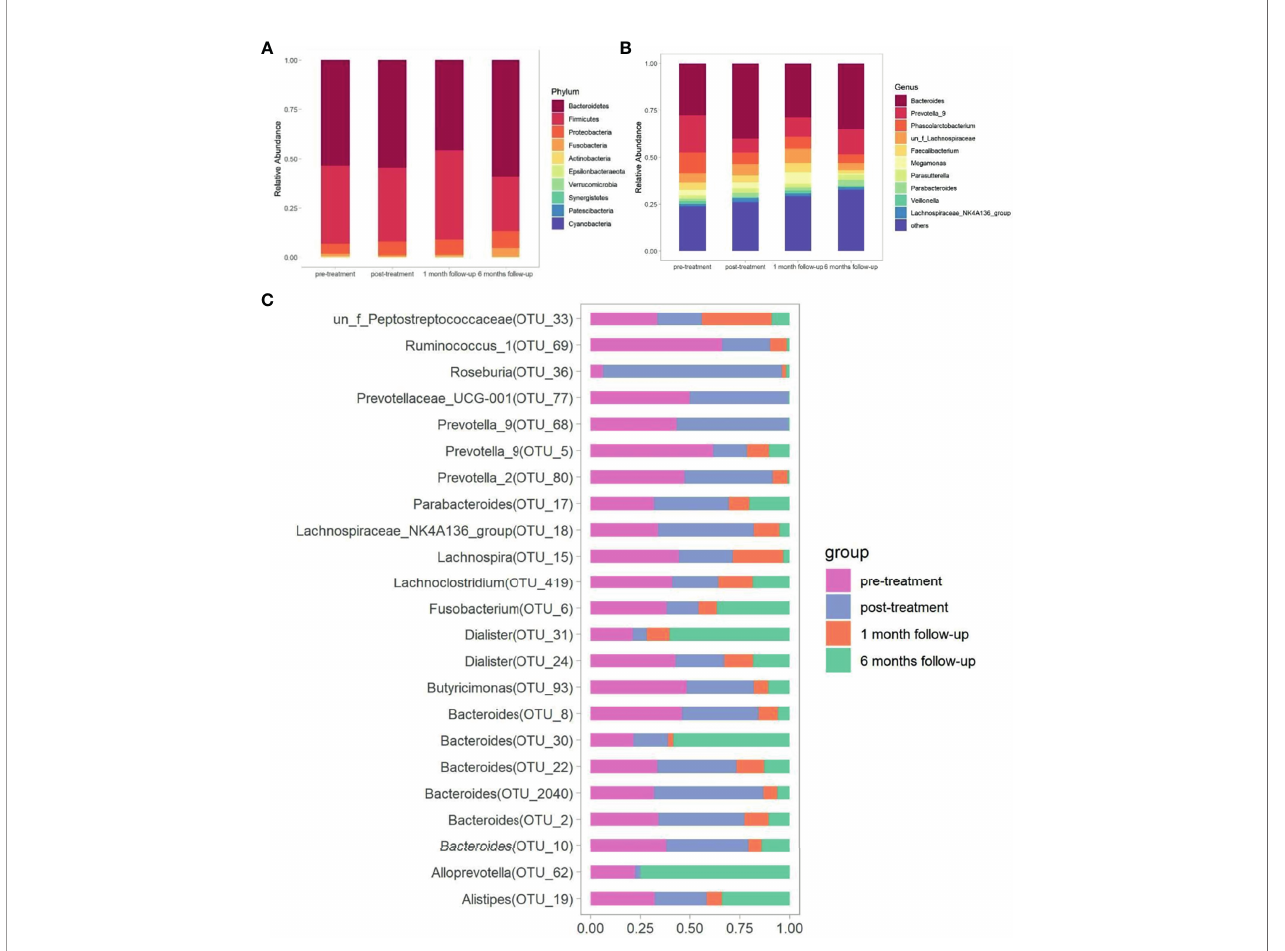
FIGURE 3 | Comparison of gut microbiota at different time points. The bacterial phylum taxa (A) and genera (B) distribution pattern at different time points. (C) The distribution of signi fi cantly distinguished OTUs at different time points screened by Kruskal-Wallis